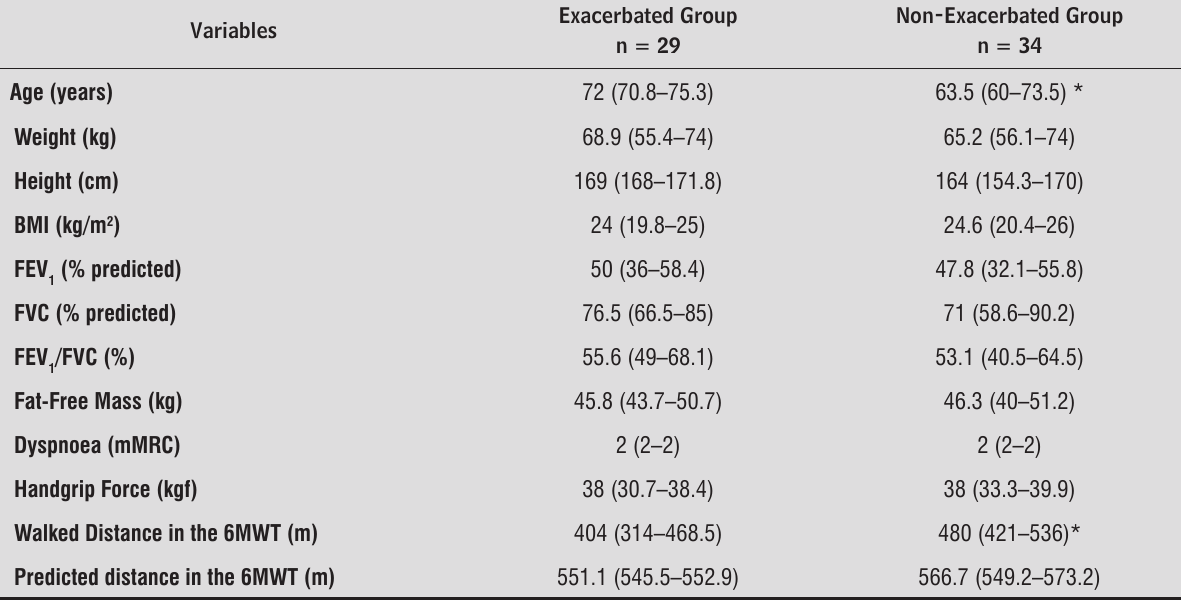
Table 1 - Anthropometric, spirometric, body composition characteristics and baseline values of dyspnoea, handgrip force, walked distance and predicted distance in the 6MWT of both groups